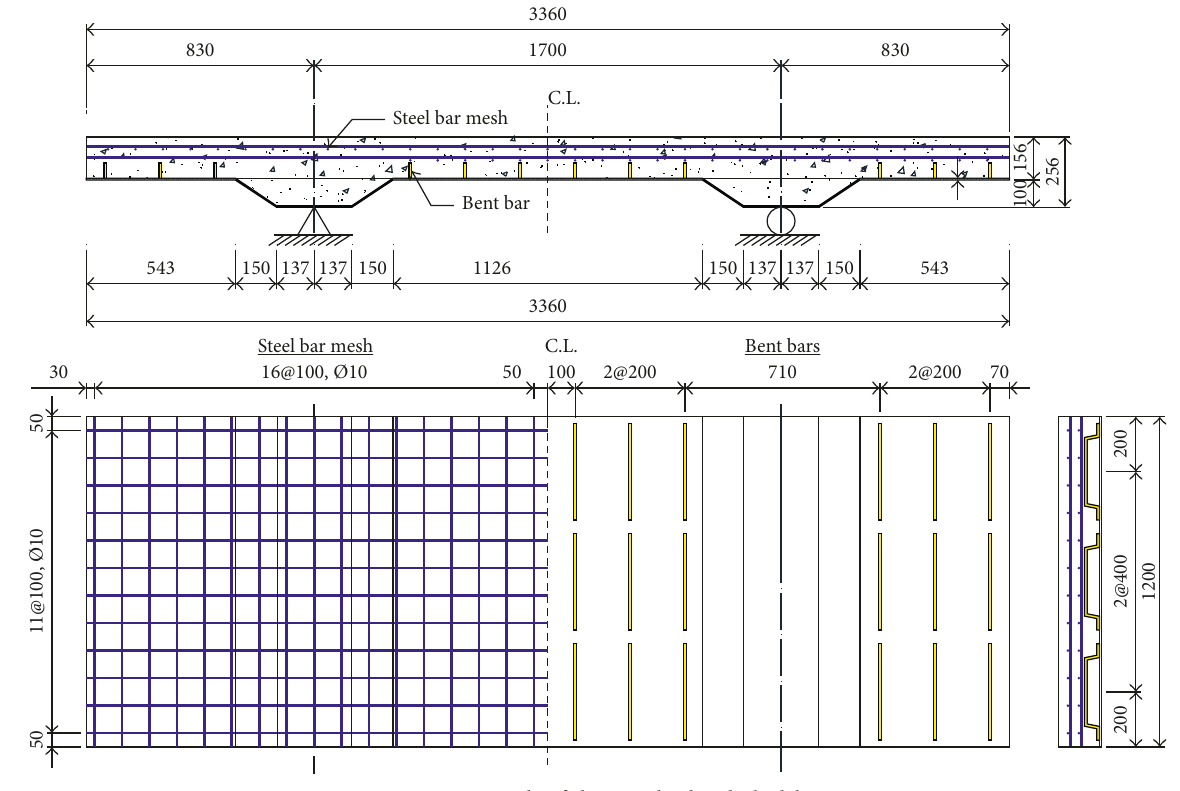
Figure 4: Details of the SCC bridge deck